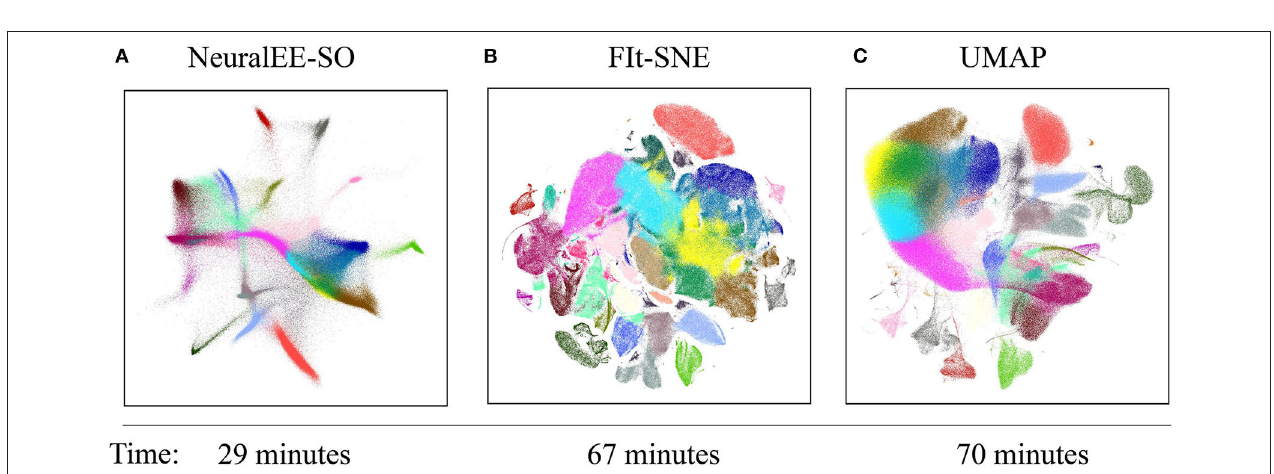
FIGURE 4 | Embedding results on 1.3 million mouse brain cells dataset. (A) NeuralEE-SO with batch size as 5,000. (B) FIt-SNE. (C) UMAP. Labels represent different clusters of Louvain community detection algorithm (Blondel et al., 2008). As NeuralEE belongs to parametric methods, when applied on million-size data, it could return several outliers on the embedded space, we manually delete them to make layout tighter. The raw embedding is showed at Supplementary Figure 7 .